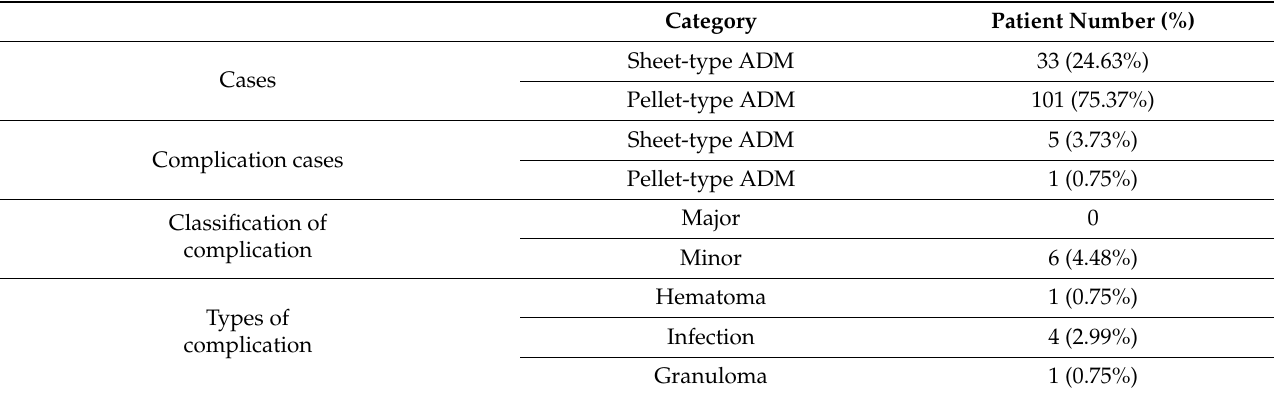
Table 2. Comparison between ADM